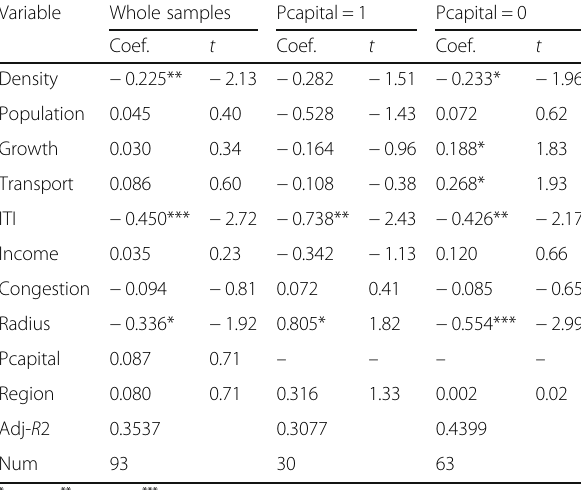
Table 3 Regression results of empirical